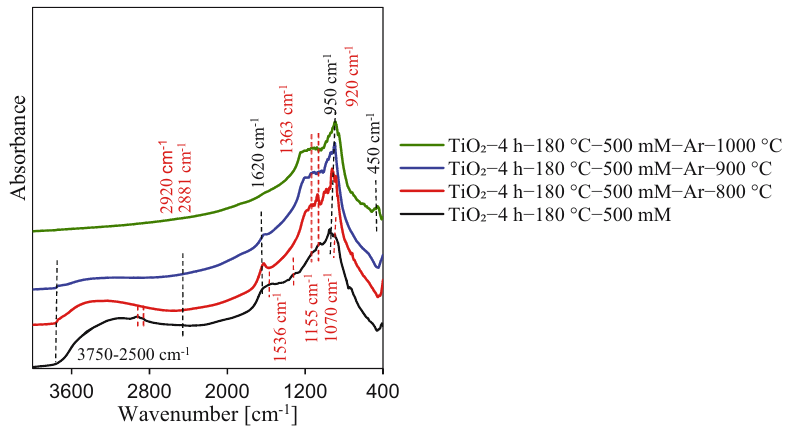
Figure 1: Di ff use re fl ectance Fourier transform infrared spectra of APTES/TiO 2 nanomaterials [ 20 ]